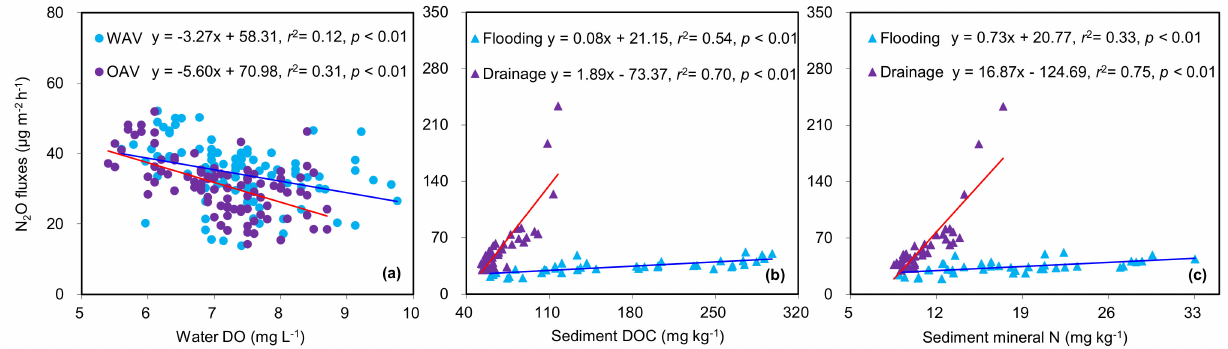
Figure 5. Dependence of N 2 O fluxes on water and sediment parameters in the freshwater crayfish– fish aquaculture ponds. ( a ) Dissolved oxygen (DO) in water; ( b ) dissolved organic carbon (DOC); in sediment; ( c ) sediment mineral N (NH 4+ + NO 3 −